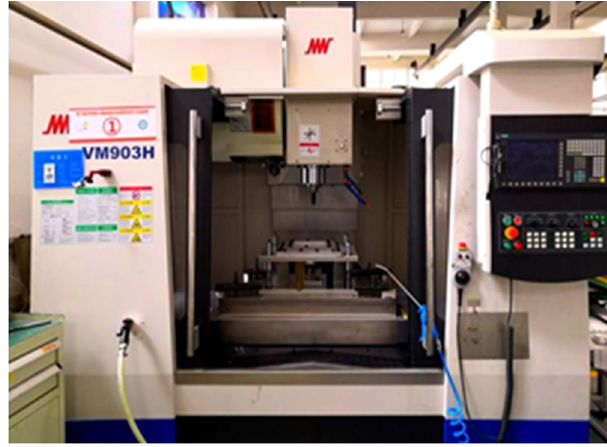
Fig. 2. The machine of electric hot